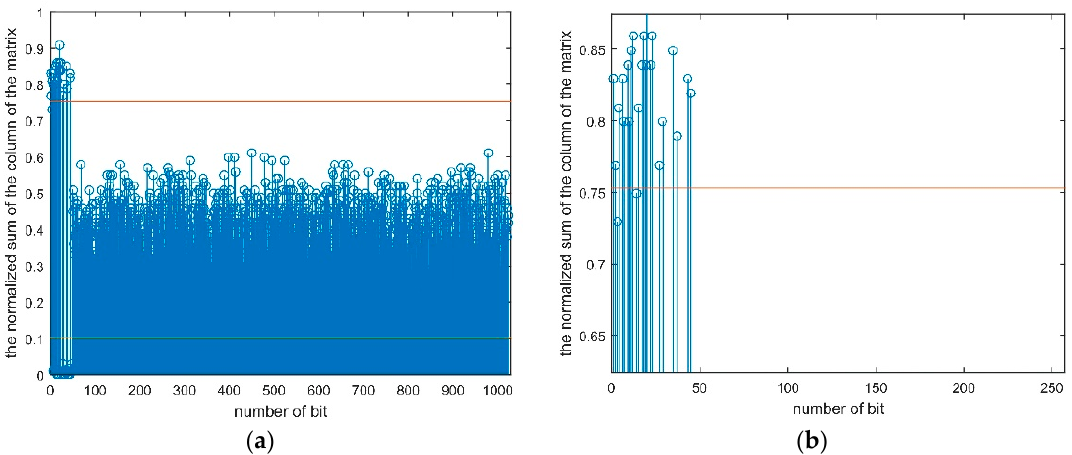
Figure 2. ( a ) This is the figure of Y sum* with BER = 0.08, α = 3. ( b ) This is the partial enlargement of Figure 2a at the frame header. There are two “1”s below the up threshold, causing the missing judgement.